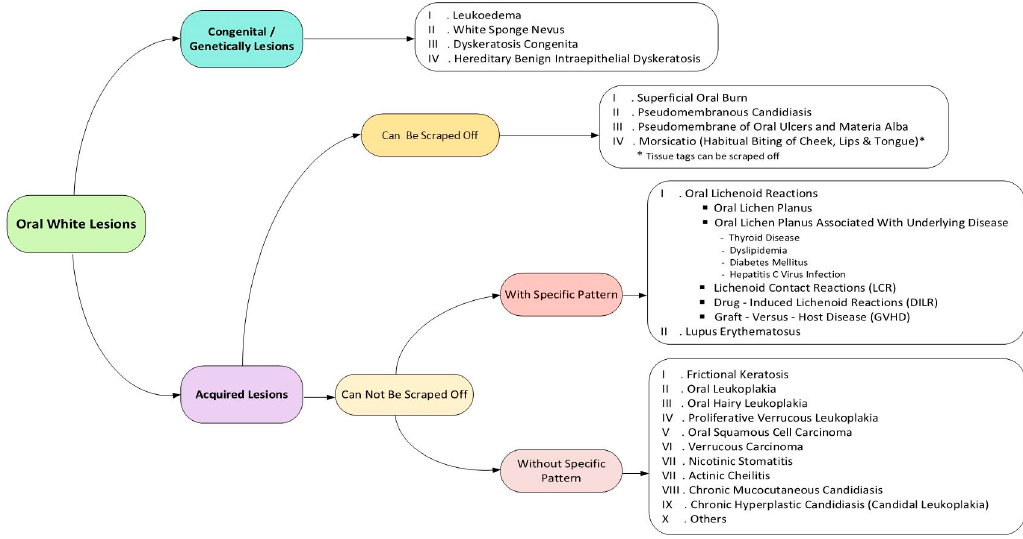
Figure 1. Decision tree of oral white lesions.